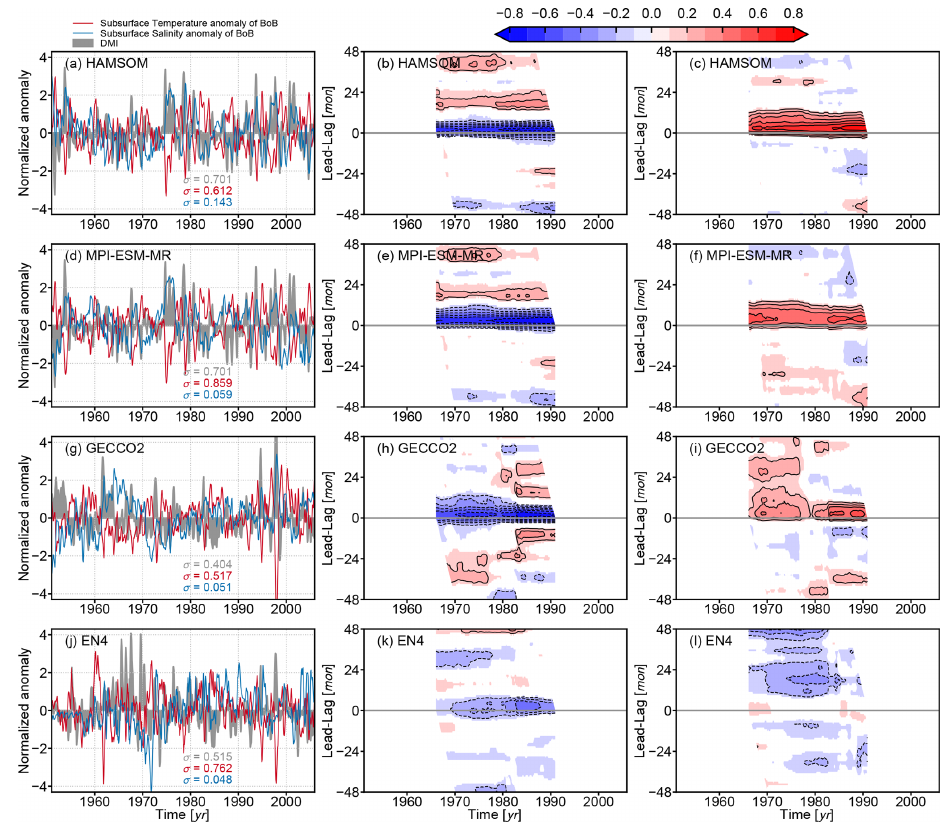
Figure 7. Normalized 3-month running mean of DMI, temperature anomaly, and salinity anomaly at subsurface (100m) of the BoB from HAMSOM (a) , MPI-ESM-MR (d) , GECCO2 (g) , and EN4 (j) , respectively, are shown in the first column. The standard deviation σ is labeled with the corresponding color. Lead–lag running Pearson correlation coefficient with a window of 30 years between the DMI and the subsurface temperature (salinity) anomaly from each data set is shown in the second (third) column, respectively. The contour intervals are 0.1. Only significant correlation coefficients with p value < 0 . 05 are